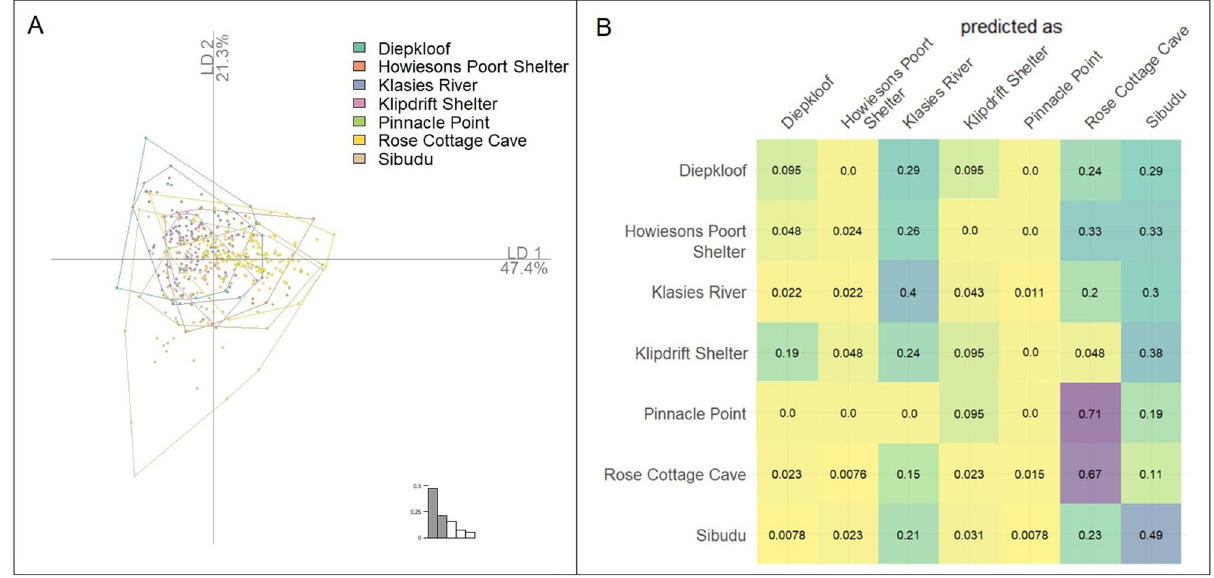
Figure 3. ( A ) Linear Discriminant Analysis (LDA) plot of the first two discriminants, which together account for 68.3% of between site shape variation. Note the lack of improvement in discrimination of sites, with the exception of a few outlying backed artifact shape configurations from Sibudu. ( B ) Results of cross validation tests over LDA inputs show the frequency the site of the backed artifact has been correctly predicted. The rows show the site and the columns show the prediction. Rose Cottage Cave had the highest frequency of correct prediction (67%) followed by Sibudu (49%), and Klasies River (40%). Diepkloof, Howiesons Poort Shelter,